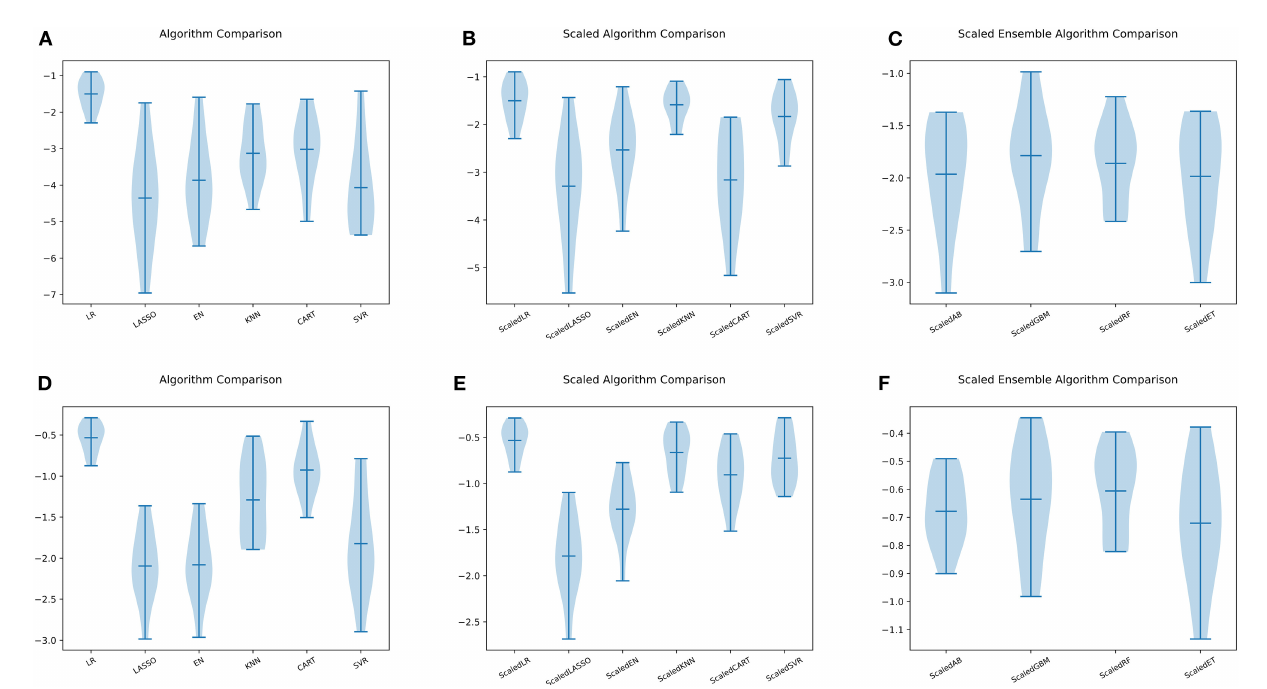
FIGURE5 Comparison of ML models. (A) Six ML algorithms for BASFI prediction before standardization. (B) Six ML algorithms previously mentioned for BASFI prediction after standardization. (C) Four ensemble ML algorithms for BASFI prediction after standardization. (D) Six ML algorithms for BASDAI prediction before standardization. (E) Six ML algorithms previously mentioned for BASDAI prediction after standardization. (F) Four ensemble ML algorithms for BASDAI prediction after standardization (LR, Linear Regressor; LASSO, Least Absolute Shrinkage and Selection Operator; EN, Elastic Net; KNN, K Nearest Neighbors; CART, Classification and Regression Trees; SVR, Support Vector Regression; AB, AdaBoost Regressor; GBM, Gradient Boosting Machine Regressor; RF, Random Forest Regressor; ET, Extra Tree